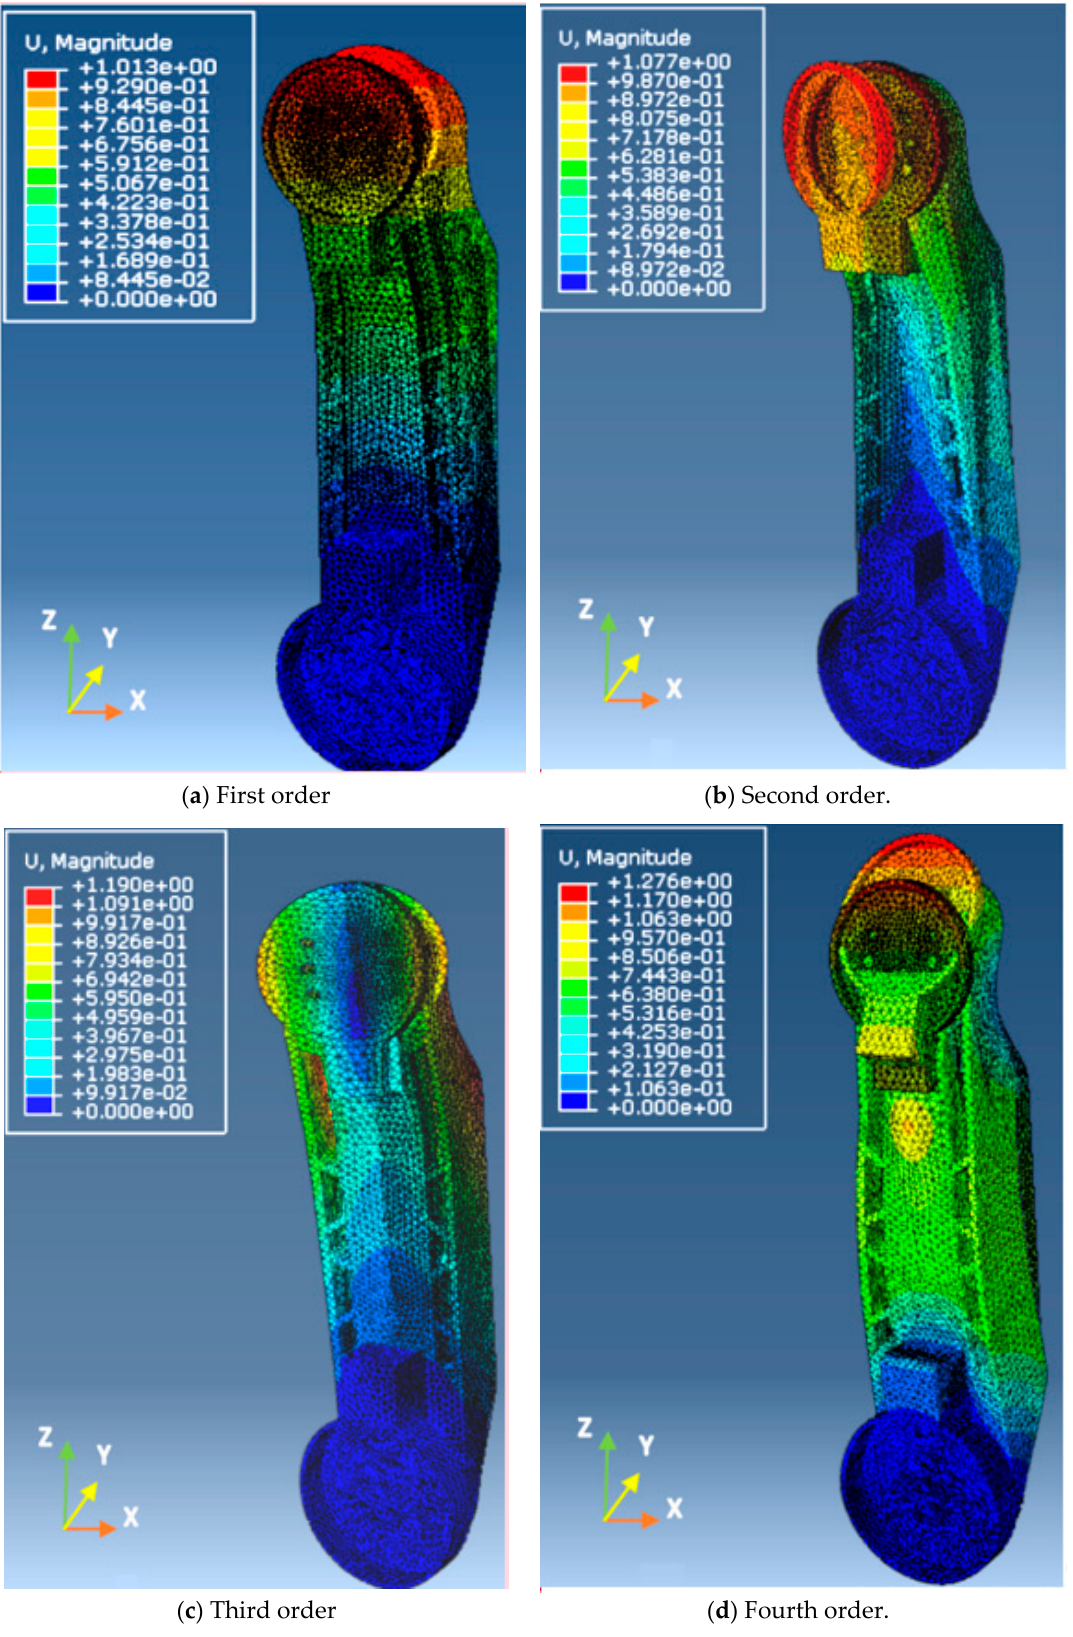
Figure 13. The vibration modes of the upper arm, ( a ) first order, ( b ) second order, ( c ) third order, and ( d ) fourth order.